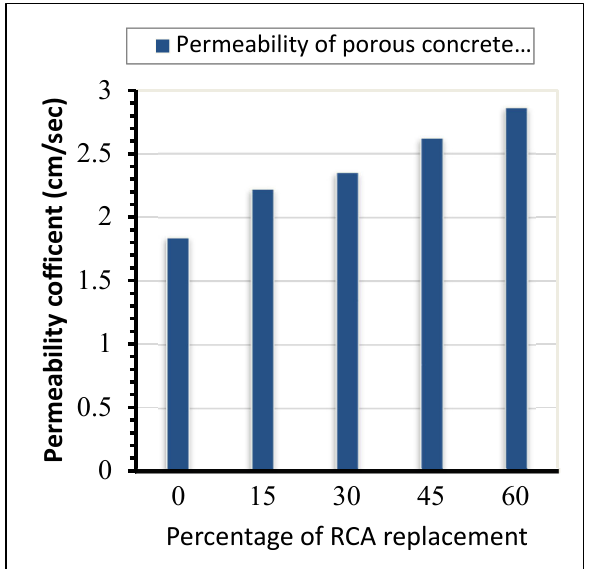
Figure 7. Permeability coefficient.